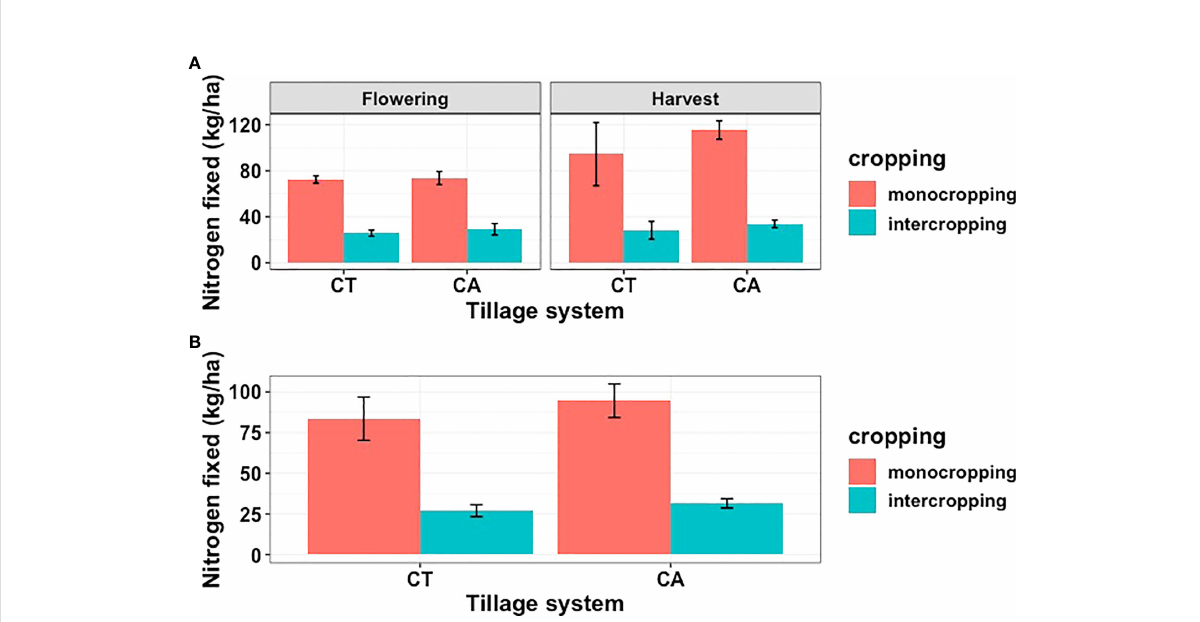
FIGURE 4 The amount of N fi xed in kilogrammes per hectare as affected by cropping system, (A) at different sampling times, and (B) the